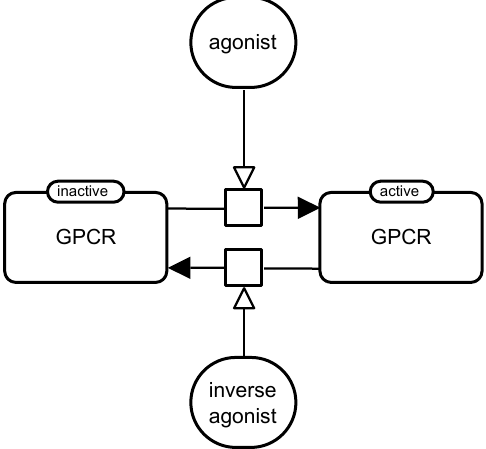
Figure 2.27: The reversible activation of a G-protein coupled receptor.